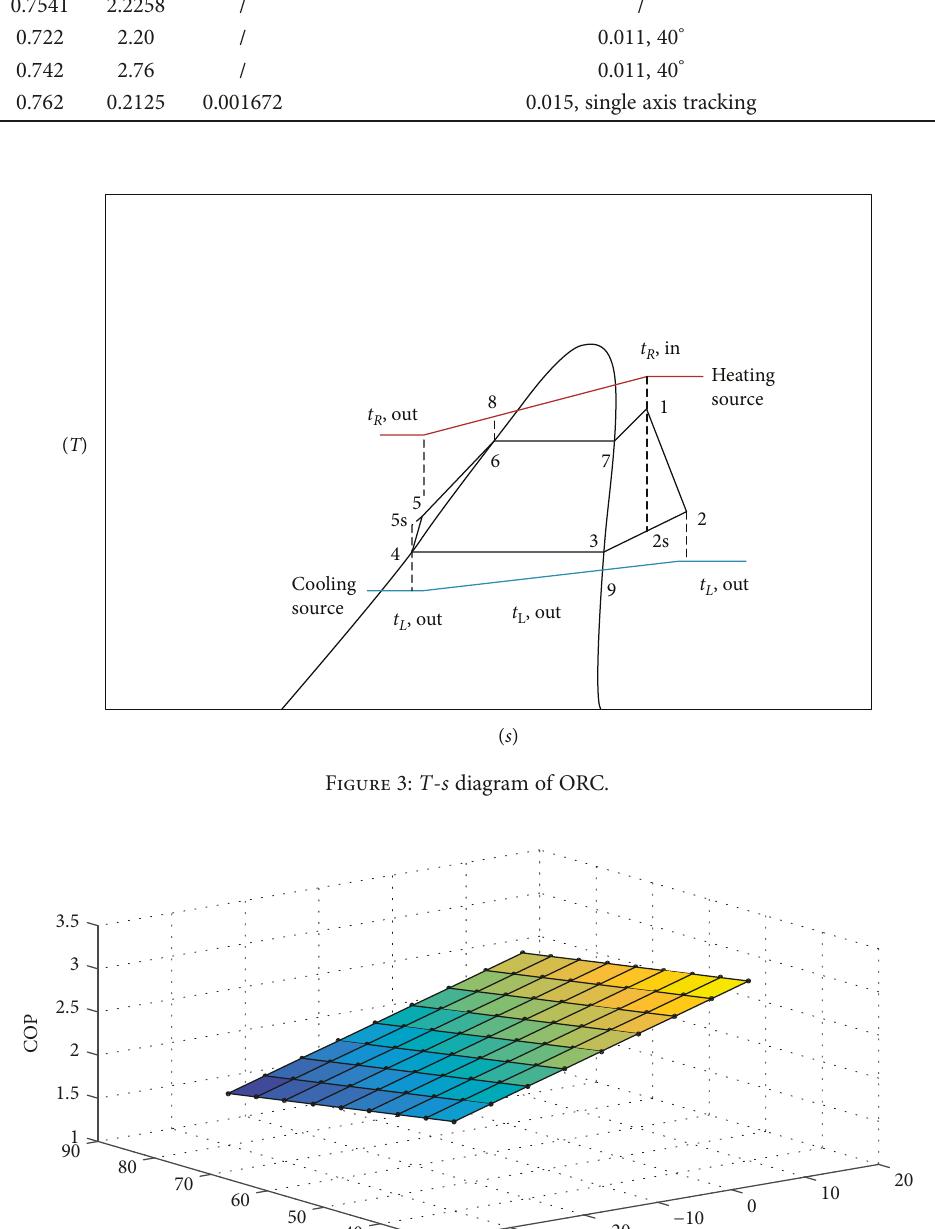
air source heat 2